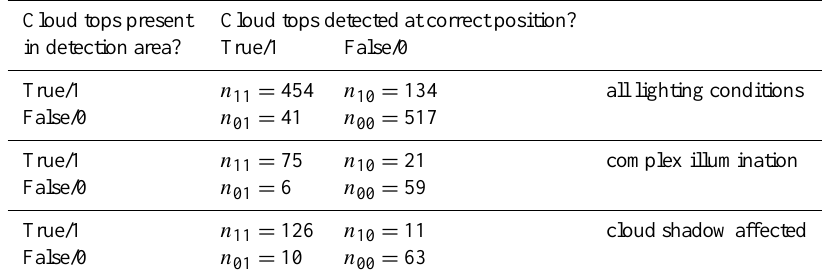
Table 2. Confusion matrices for the visual validation. Cloud tops present Cloud tops detected at correct position?